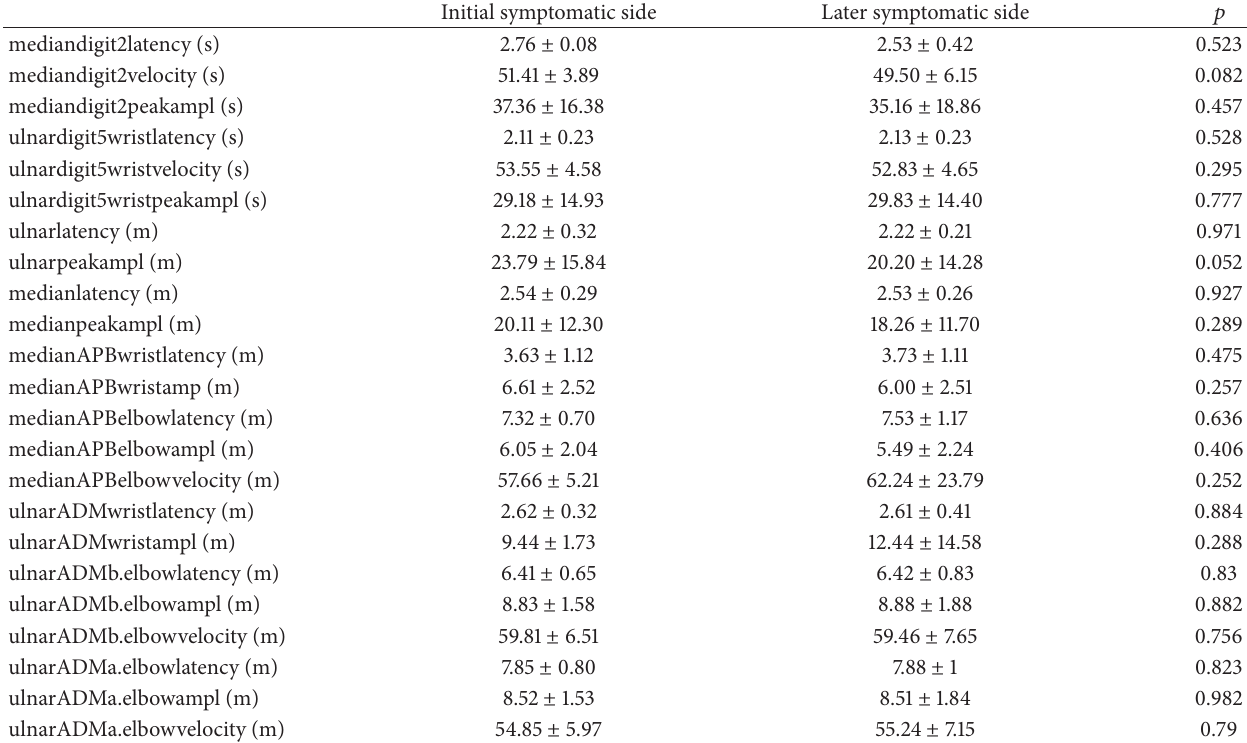
Table 4: Correspondence of mean indices of electrophysiologic parameters between initial and later symptomatic sides in PD patients. Initial symptomatic